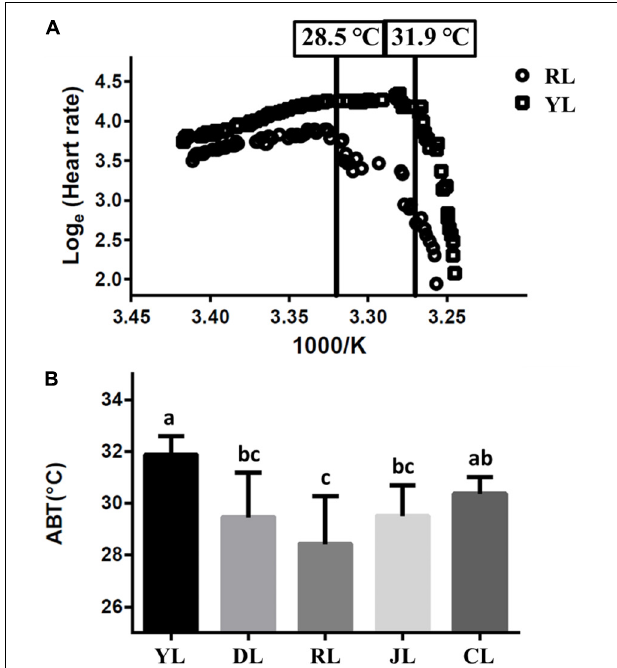
FIGURE 1 | The Arrhenius breakpoint temperature (ABT) for different Pacific abalone lines. (A) The Arrhenius plots for YL and RL. (B) The ABTs for the five selective lines. Bars labeled with different letters are significantly different ( p < 0.05).